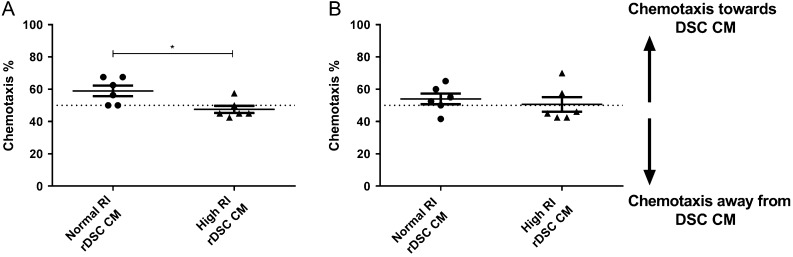
Effect of rDSC CM from normal and high RI pregnancies on chemotaxis of SGHPL-4 cells. SGHPL-4 cells were cultured in chemotaxis chambers to analyse chemotactic capacity of normal and high RI rDSC CM. Non-directional movement of cells gives expected chemotaxis of 50%. (A) Normal RI rDSC CM from pregnancies <10 weeks gestation is significantly more chemotactic to SGHPL-4 cells than high RI rDSC CM from pregnancies at <10 weeks gestation. (B) Normal and high RI rDSC CM from pregnancies >10 weeks gestation have no chemotactic effect on SGHPL-4 cells (n = 6). Paired t-test, data shown as mean ± s.e.m., *P < 0.05.